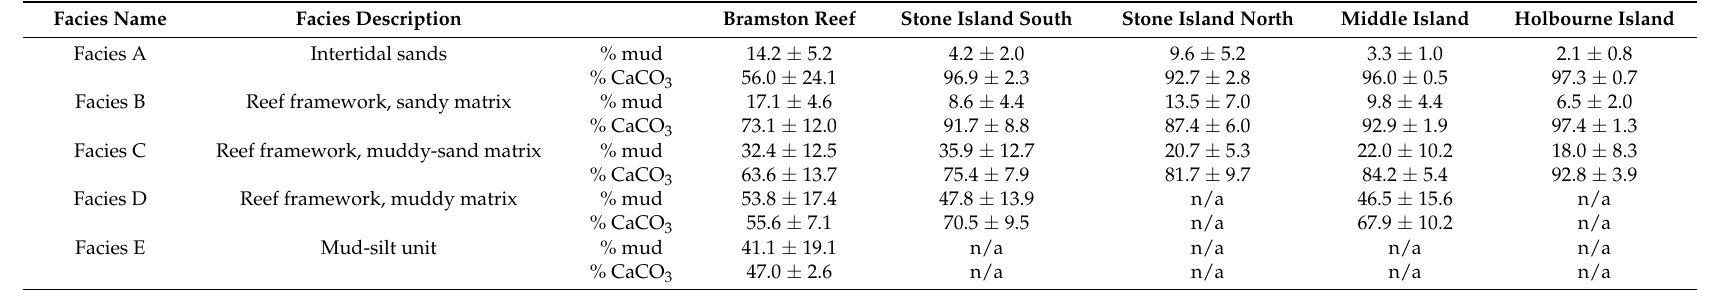
Table 2. A comparison of average ( ± 1 σ ) mud content (<63 microns) and carbonate content (CaCO 3 ) of the sediment matrix within upper facies (A–B) and lower facies (C–E) in the percussion cores from each study